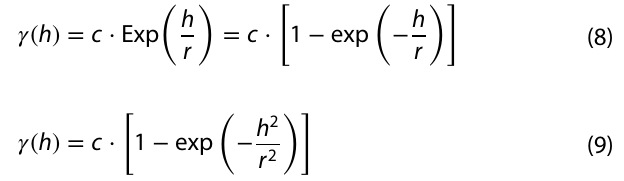
Table 1 Statistical characteristics of meteorological parameters